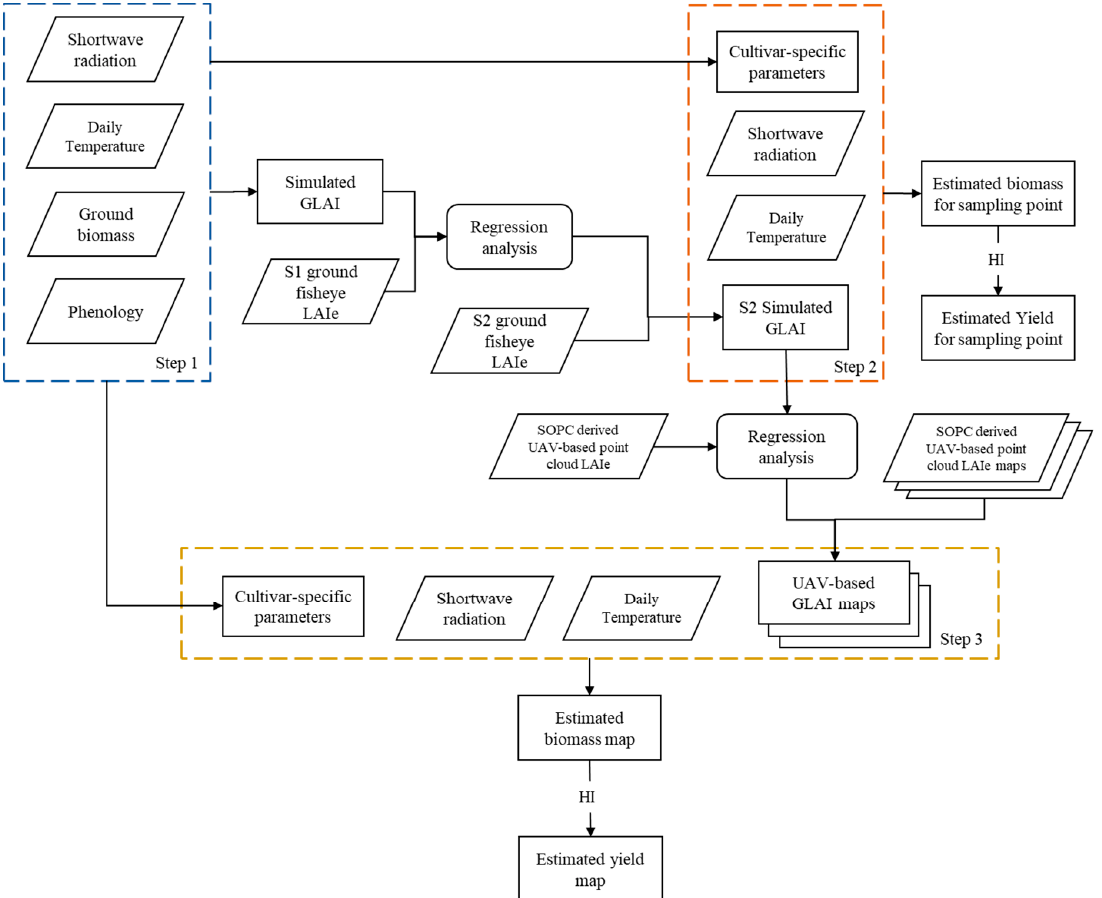
Figure 6. Flowchart shows the steps to perform UAV-based winter wheat yield estimation. Step 1 determines the cultivar-specific parameters of winter wheat. Step 1 and 2 established the relationship between simulated green leaf area index (GLAI) and UAV-based point cloud LAIe. Step 3 applies the UAV-based GLAI maps and cultivar-specific parameters in simple algorithm for yield (SAFY) model to estimate final biomass and yield map.